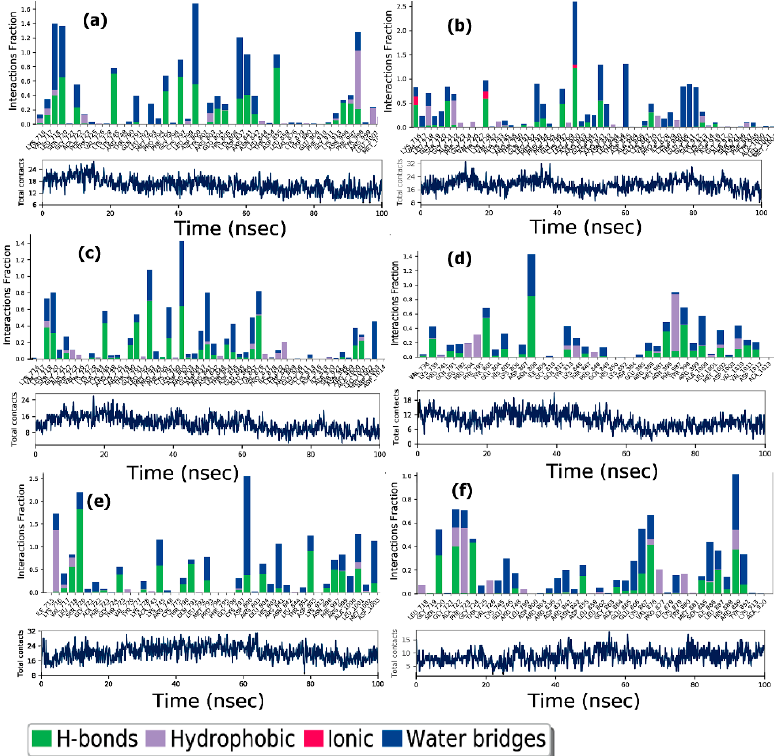
Figure 14. Protein ligand contacts of EGFR ligand complexes. ( a ) with RMAPep (top); total number of contacts with RMAPep (bottom); ( b ) with RMAMut1 (top); total number of contacts with RMAMut1 (bottom); ( c ) with GLAMut1 (top); total number of contacts with GLAMut1 (bottom); ( d ) with GLAMut2 (top); total number of contacts GLAMut2 (bottom); ( e ) with CGA-Mut4 (top); total number of contacts with CGA-Mut4 (bottom); ( f ) with CSAMut4 (top); total number of contacts with CSAMut4 (bottom).